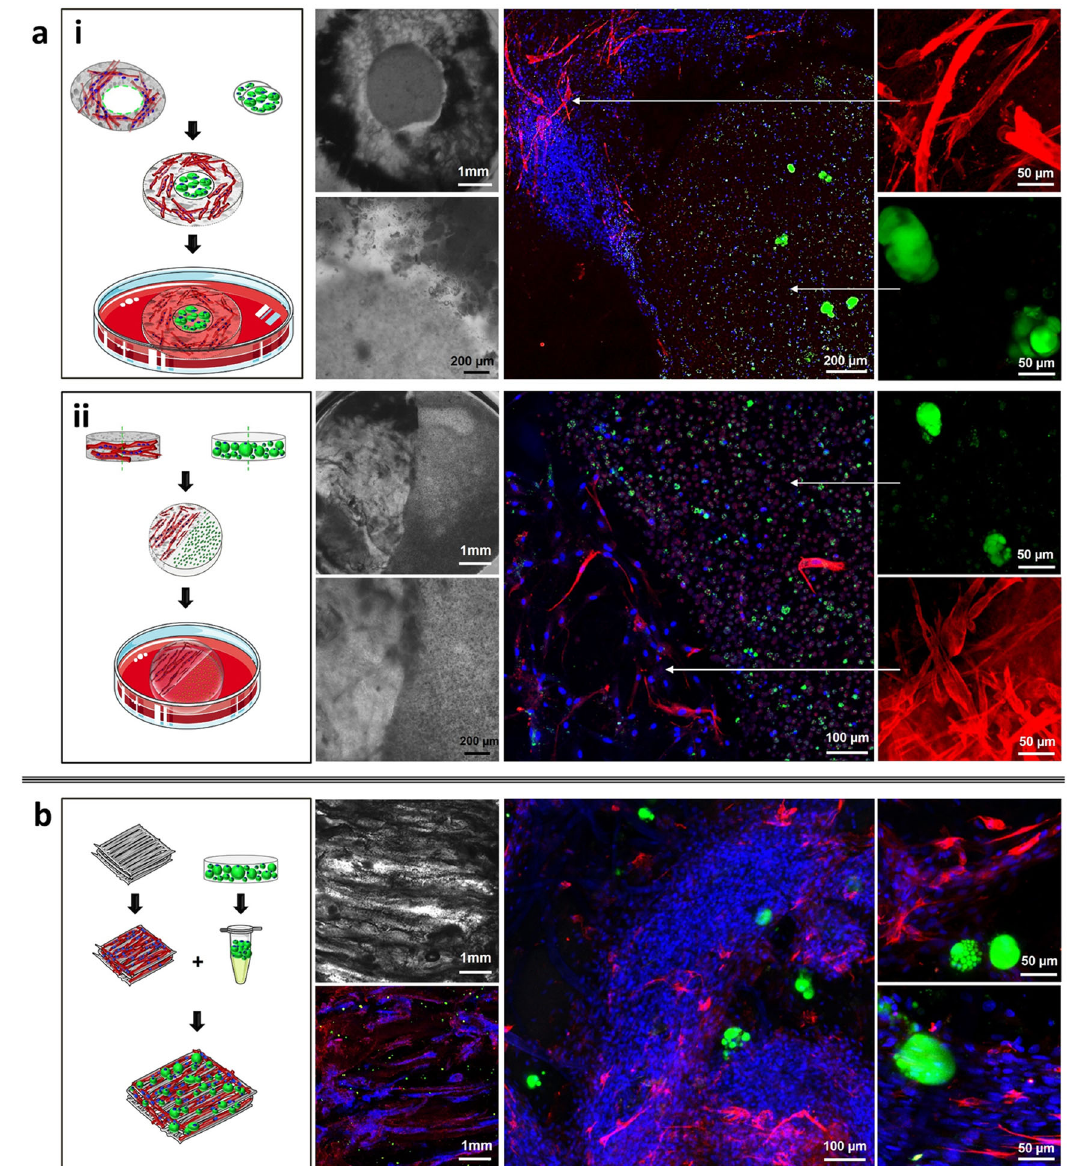
Fig. 4 Engineered bovine adipose-muscle marbled-like construct. a Engineered mold-cast marble-like constructs composed of bovine fat and muscle in a (i) ring and a (ii) semicircular con fi guration. The outer ring/left semi-circle is a lyophilized casted alginate-RGD plug onto which bovine satellite cells were seeded and myogenically differentiated into myotubes. The inner ring/right semi-circle is an alginate plug loaded with differentiated BMSCs. The integrated constructs were incubated in adipogenic maturation medium for 1 week. From left to right: Illustration of the attachment process, bright fi eld images in low and high magni fi cations, and confocal images of lipid and desmin staining of constructs (green, LipidTox; red, Desmin; blue, DAPI) in low and high magni fi cations. b Marbled-like construct on a 3D-printed scaffold composed of extracted mature adipocytes (differentiated BMSCs) within bovine engineered muscle tissue. From left to right: illustration of the construct fabrication process, bright fi eld image, and confocal images of lipid and desmin staining of constructs (green, LipidTox; red, Desmin; blue, DAPI) at different magni fi cations. Image credits: this fi gure was created using elements from Servier Medical Art